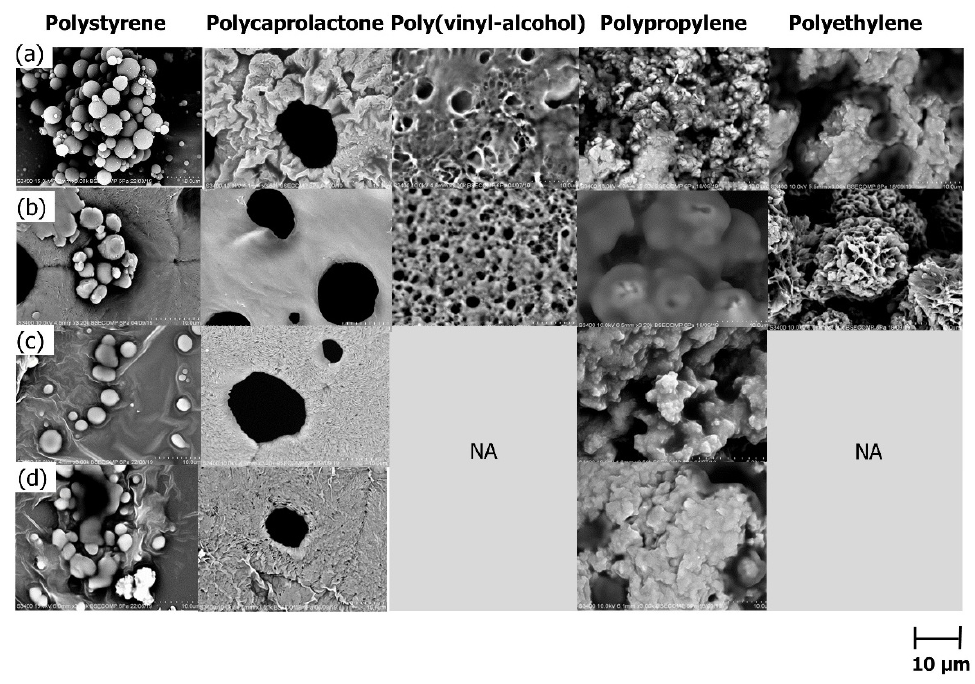
Figure 2. Polymeric templates from different types of polymer at different concentrations ( a ) 10 wt%, ( b ) 20 wt%, ( c ) 30 wt%, and ( d ) 40 wt%. ( b ) 20 wt%, ( c ) 30 wt%, and ( d ) 40